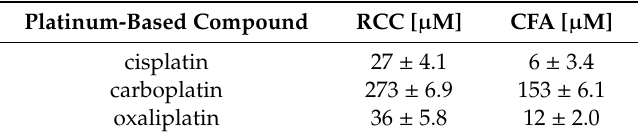
Figure 2. Cytotoxicity of platinum compounds in A498 cells. ( A ): Relative cell count (RCC) after treatment with cisplatin, carboplatin or oxaliplatin. A498 cells were incubated for 1 h with cisplatin (10, 20, 40, 80 µ M), carboplatin (80, 160, 320, 500 µ M) or oxaliplatin (20, 40, 80, 160 µ M). After 72 h postcultivation, cell count was determined. RCC was obtained by normalization to the untreated control. The mean values are shown of three independent experiments ± standard deviation. ( B ) / ( C ): Colony formation ability (CFA) of A498 cells after treatment with ( B ) cisplatin or oxaliplatin or ( C ) carboplatin. Cells were incubated for 1 h with cisplatin (5, 10, 15, 20 µ M), oxaliplatin (5, 10, 15, 20 µ M) or carboplatin (50, 100, 150, 200 µ M). Afterwards, cells were cultivated for 12 days for colony formation. Colonies were counted and the treated samples were normalized to the untreated control. The mean values are shown of three independent experiments ± standard deviation. Table 1. IC 50 values of cisplatin, carboplatin and oxaliplatin determined in A498 cells by relative cell count (RCC) and colony formation ability